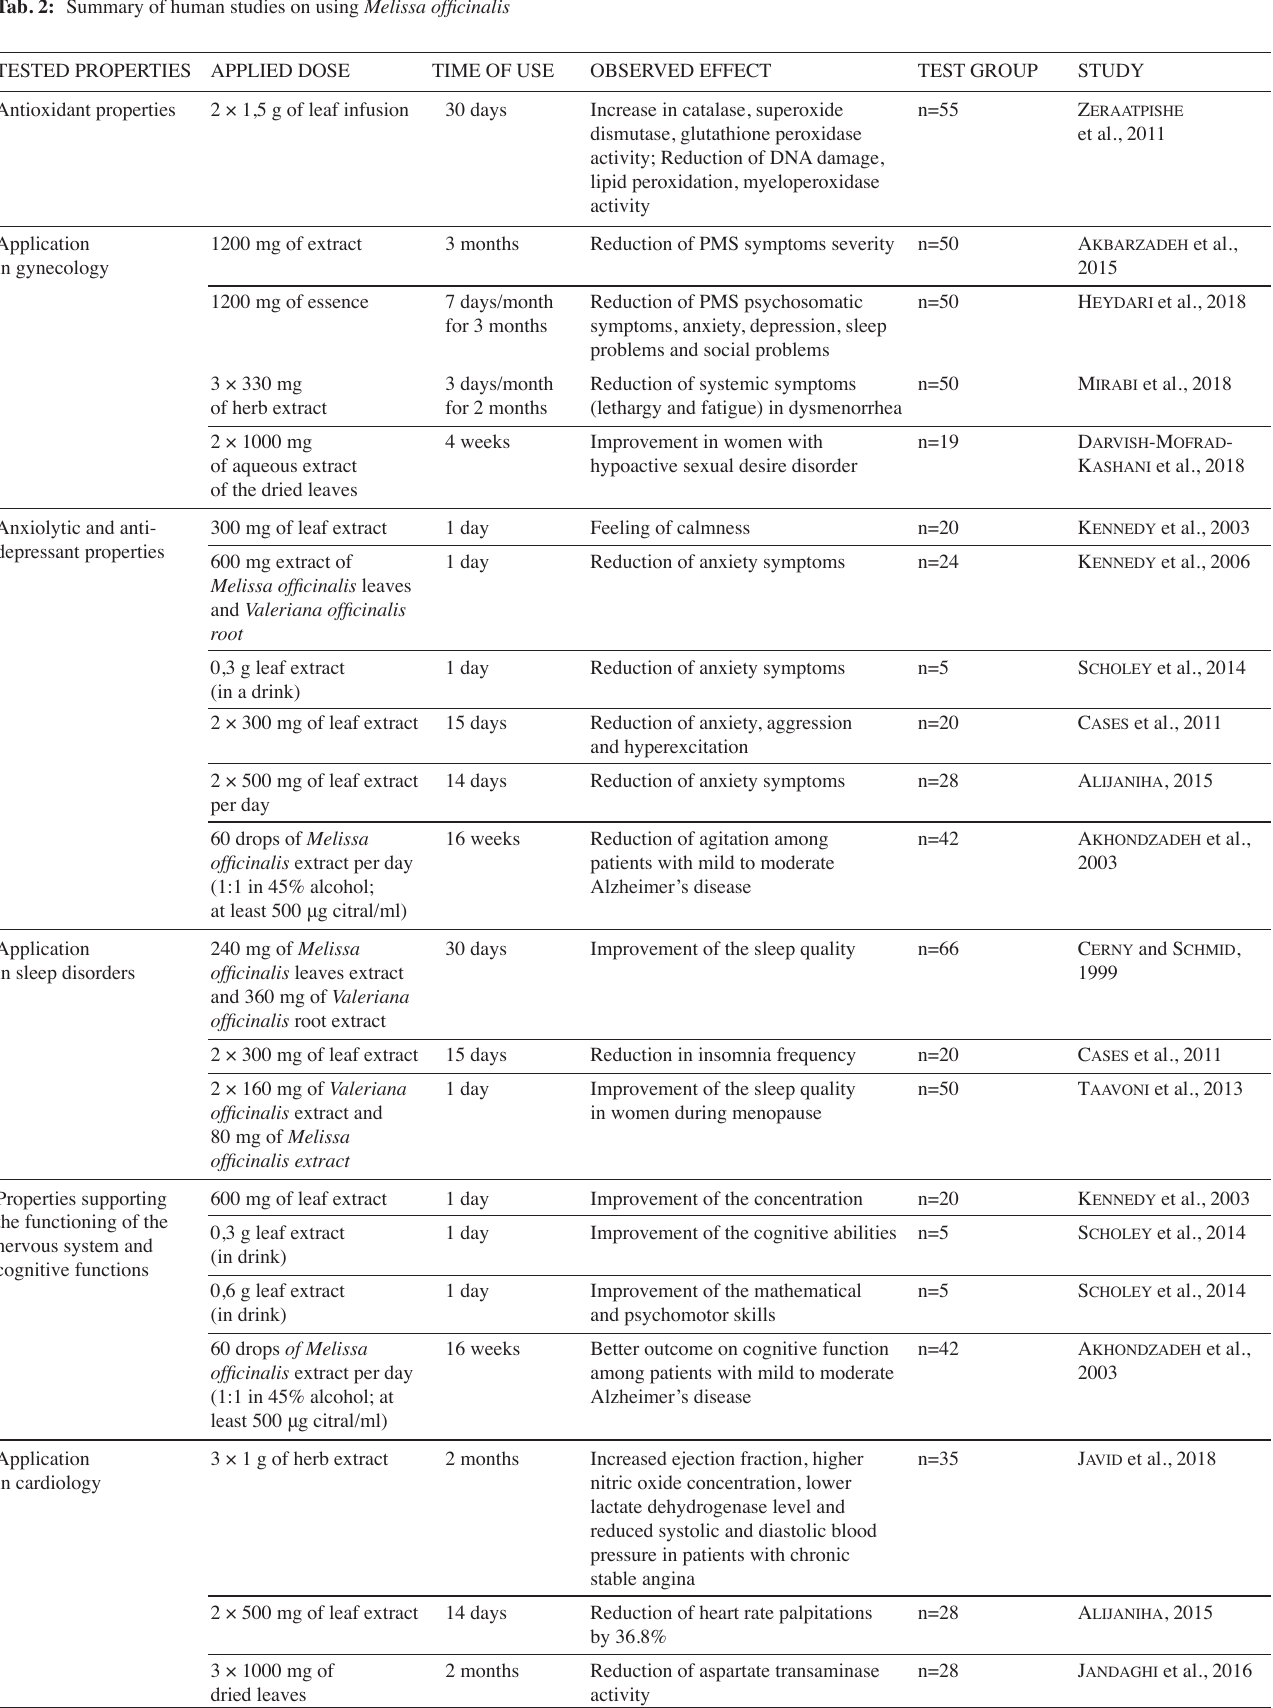
Tab. 2: Summary of human studies on using Melissa officinalis TesTed PrOPerTies aPPlied